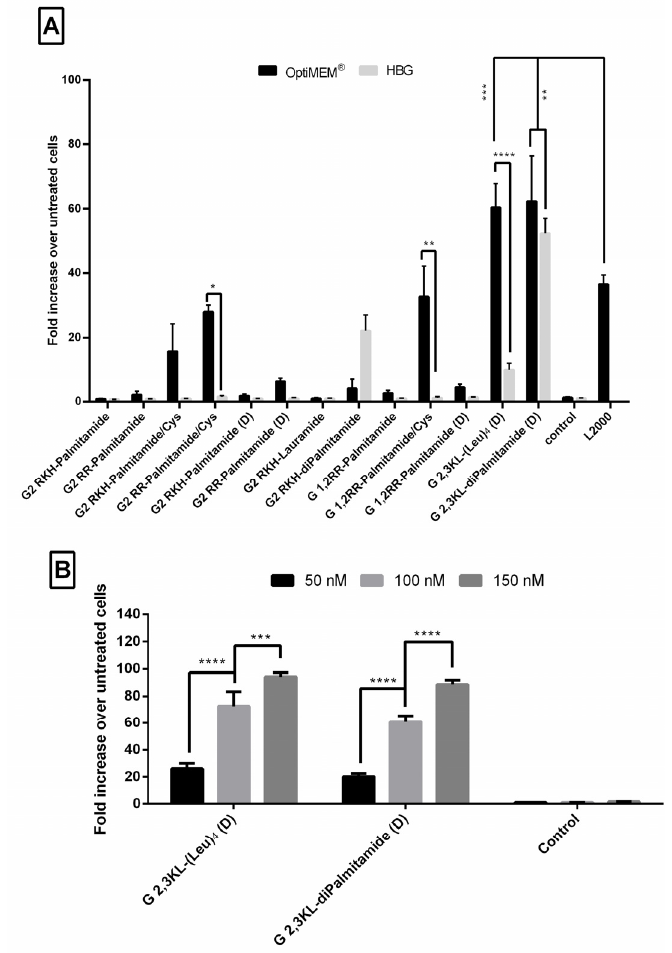
Figure 2. Fold increase in luciferase signals in treated cells over untreated cells after the transfection of the HeLa Luc/705 cells in serum-containing media with lipophilic Peptide Dendrimer/ON complexes. Graphs represent the fold increase in RLUs normalized to the total amount of protein and related to values for untreated cells, for thirteen different dendrimers complexed with ON (N/P ratio = 20). ON complexed with L2000 was used as positive control, while ON in the medium alone acted as a negative control. ON concentration: 100 nM. Luciferase activity was analyzed 24 h after transfection. ( A ) statistical difference between the same complex formulated in OptiMEM ® or HBG and compared to L2000. ( B ) A dose response correlation using 3 different doses of the ON (50, 100, 150 nM) complexed with the best performing 3rd generation dendrimers. Each bar represents the mean with the SEM of at least three independent experiments performed in triplicate ( n ≥ 3). p -values were calculated by two-way ANOVA test and the statistical differences was measured using post hoc Fisher’s LSD test. (ns: non-significant, * p ≤ 0.05, ** p ≤ 0.01, *** p ≤ 0.001, and **** p ≤ 0.0001).